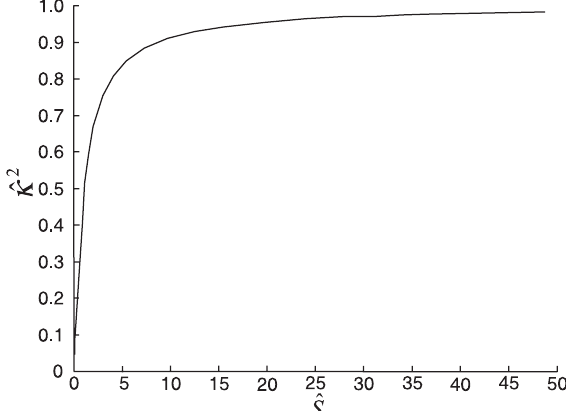
Figure 1. Simulation of the magnitude-squared coherence esti- mates ( ) for different signal-to-noise ratios ( ). Both variables are